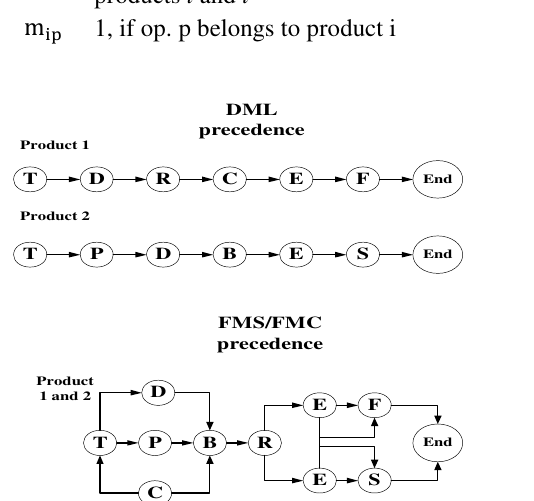
Fig. 3: Operational precedence of DMS and FMS The mathematical model containing the multi-objective functions of total cost and total time is provided through eq. 1-23. The models are adapted to DMS and FMS with the following considerations. The time and cost of setting up machines in FMS are considered negligible. On the other hand, since DMS is not designed according to cells, its cell setup cost and cell setup time values are zero. Equation (1) and (2) provide the total cost relationships for DMS and FMS, respectively. The relationships for different cost factors are provided through equations (3) to (6). Equation (7) and (8) offer the total time relationships for DMS and FMS respectively. The concerned relationships for respective components of time are produced through equations (9) to